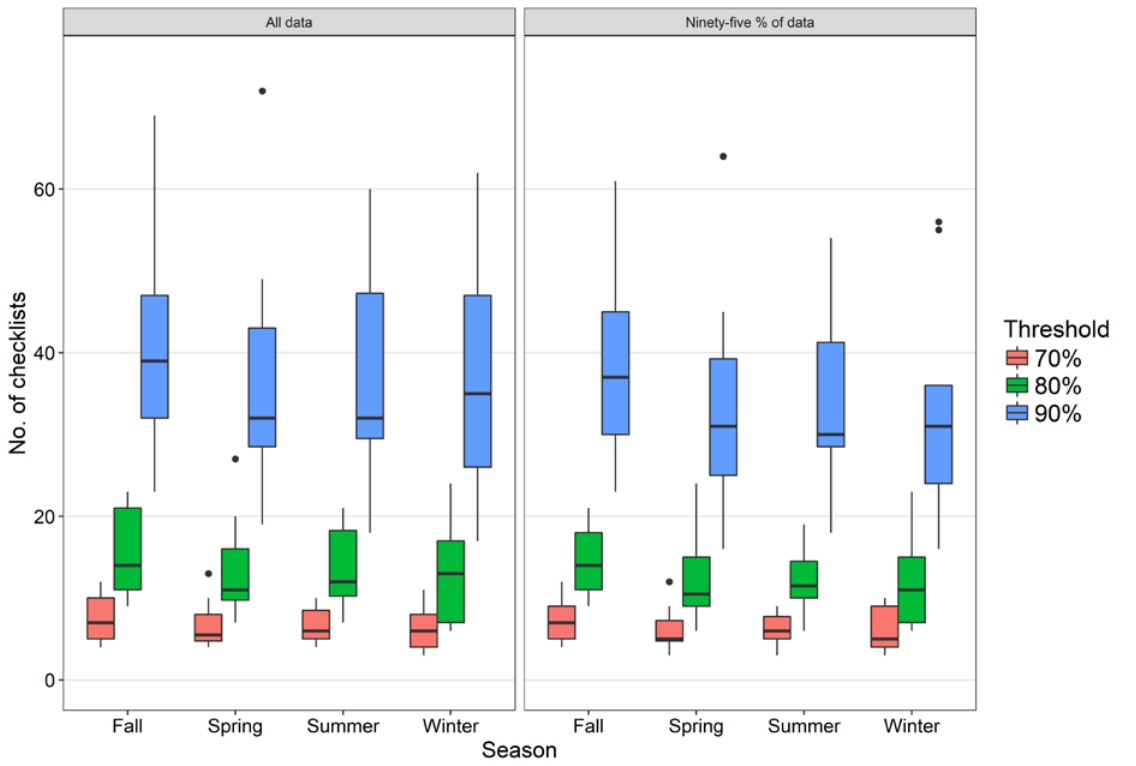
Figure A2.3. The difference among seasons and minimum number of checklists for autosimilarity (i.e., community